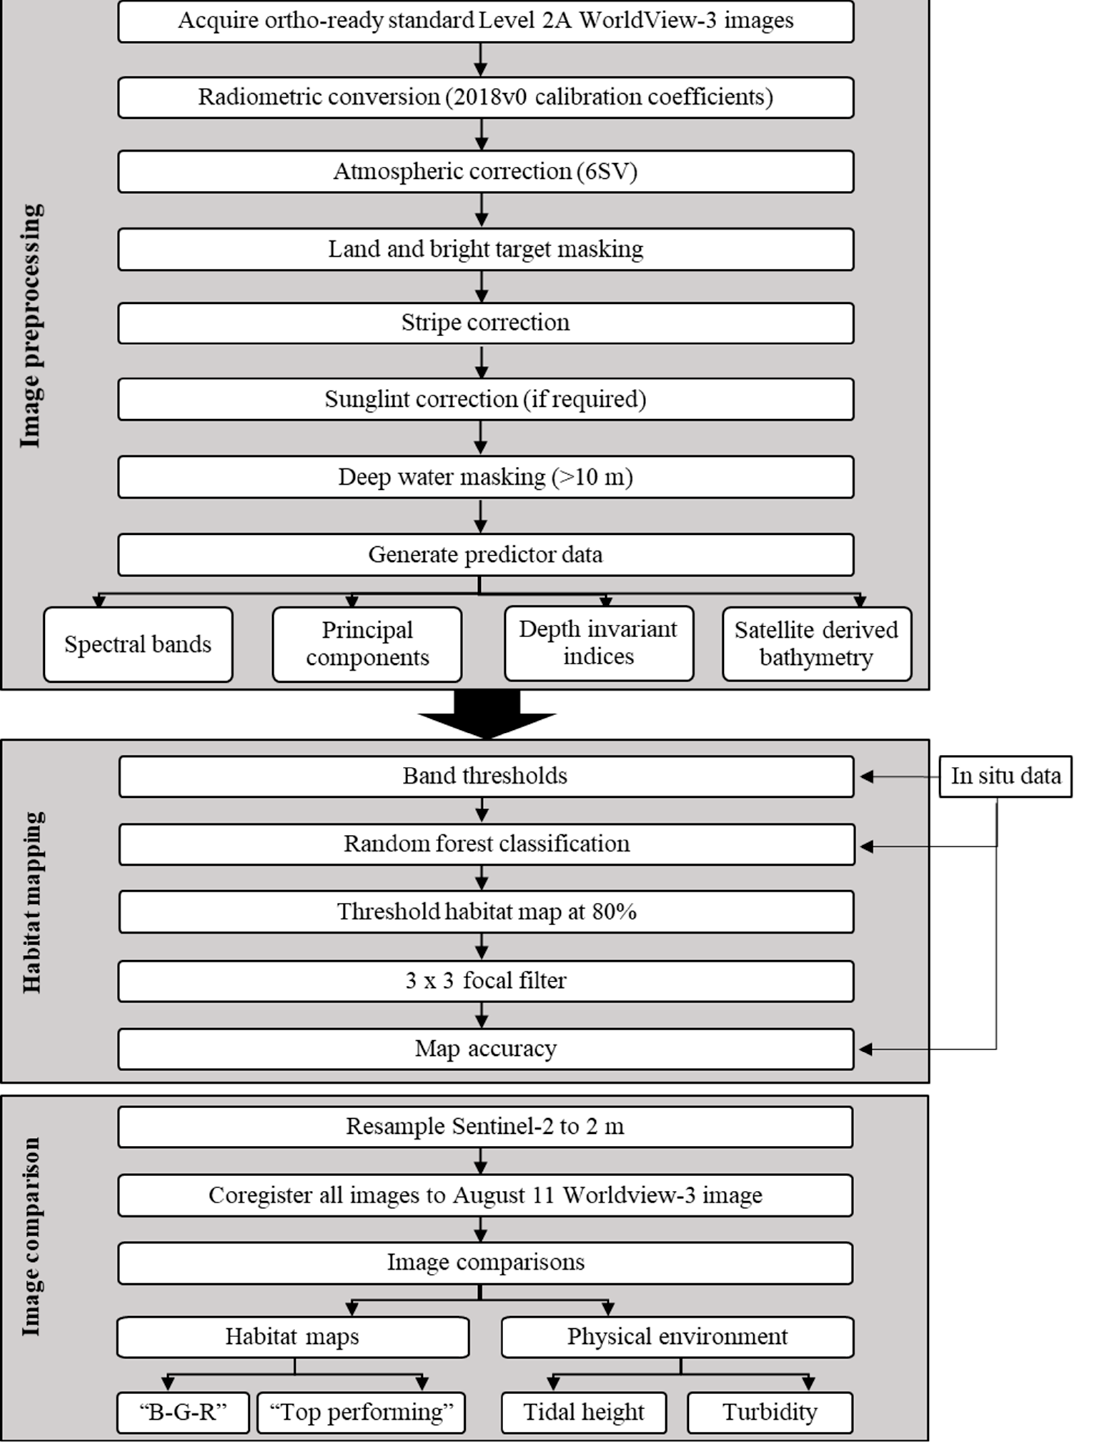
Figure 2. Methods workflow to preprocess WorldView-3 imagery, and transform the imagery into habitat maps. Note that Level 2A WorldView-3 data is at a different processing level then typical Level 2A ocean colour products. Steps that incorporated in situ data are noted where in situ data was primarily based on field survey data with some additional points that were visually identified from the satellite imagery. The image comparisons workflow shows the steps used to compare WorldView-3 habitat maps to Sentinel-2 based habitat